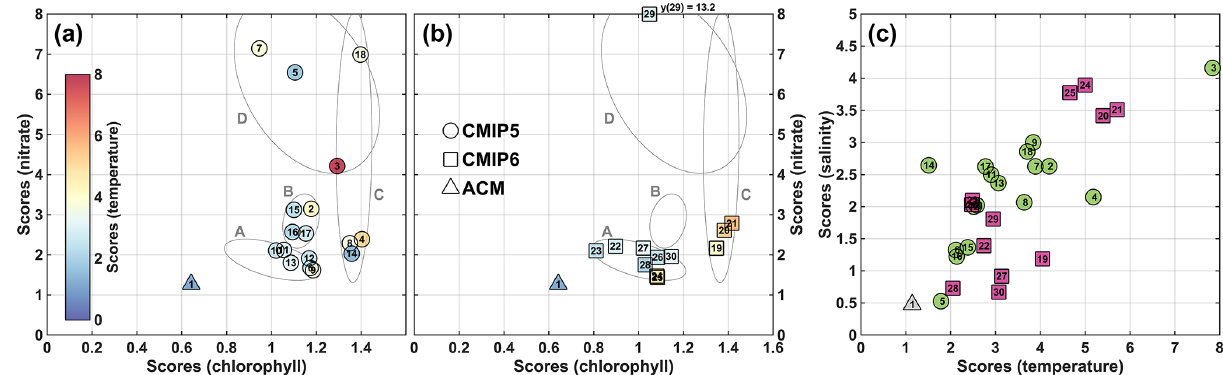
Figure 7. Model scores for surface chlorophyll ( x axis), nitrate ( y axis) and temperature (color scale) for the CMIP5 group (a) , the CMIP6 group (b) and the regional model (triangles). Salinity and temperature scores are compared in panel (c) . The gray ellipsoids indicate the groups A–D (see text) and are the same in panels (a) and (b) . Table 2. Annual model scores and ranking. R represents the multivariable mean ranking and R bio the chlorophyll and nitrate mean ranking. The final rank is provided in the right column. The bold values in the overall rank indicate a possible overestimation of the rank due to low nitrate concentrations (Figs.